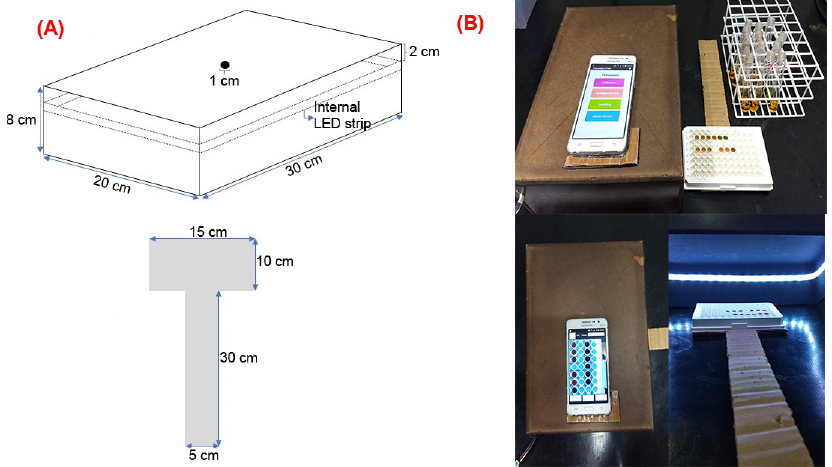
Figure 3. Design of the apparatus used for the miniaturized analysis ( A ) and the apparatus in use during COD analysis ( B ).